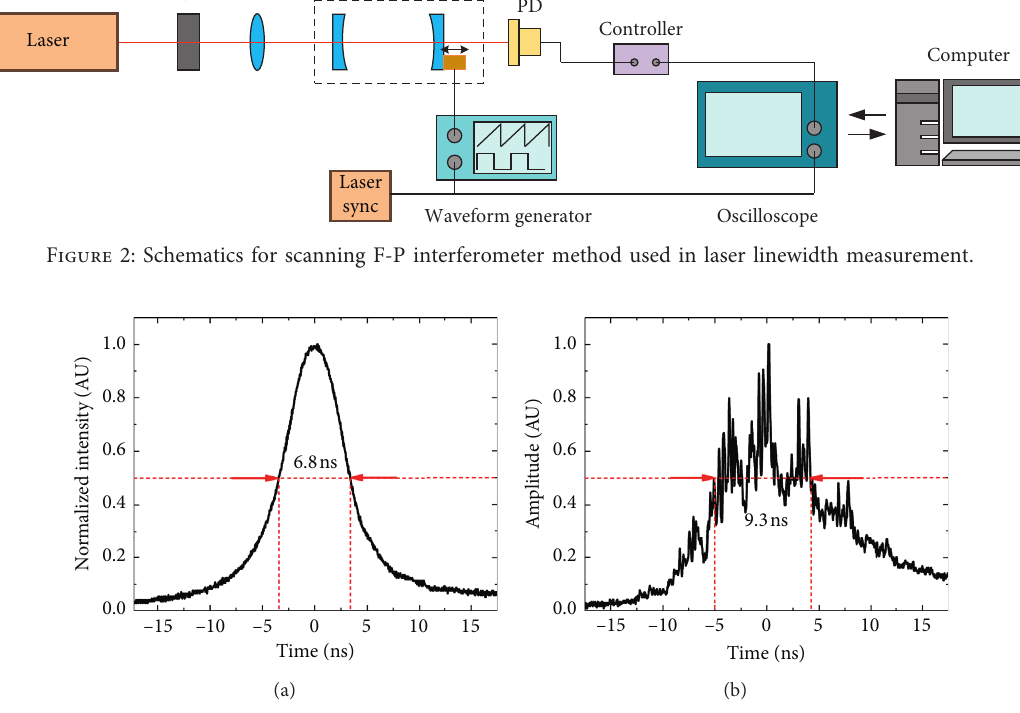
Figure 3: The temporal waveform of the output laser of the fundamental frequency: (a) the passively Q -switched laser output; (b) the actively Q -switched laser output.